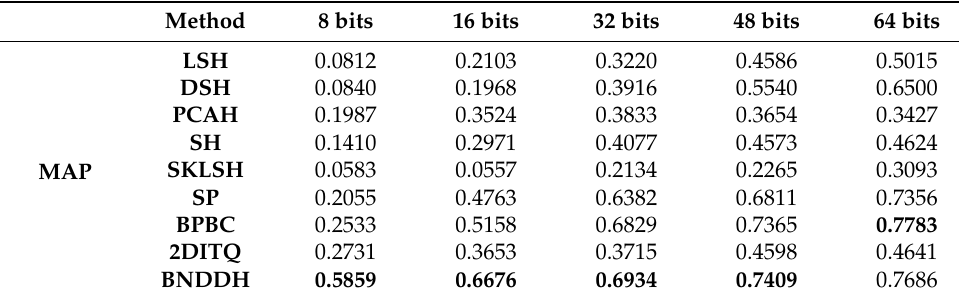
Table 4. MAP of different hash code lengths on the MNIST